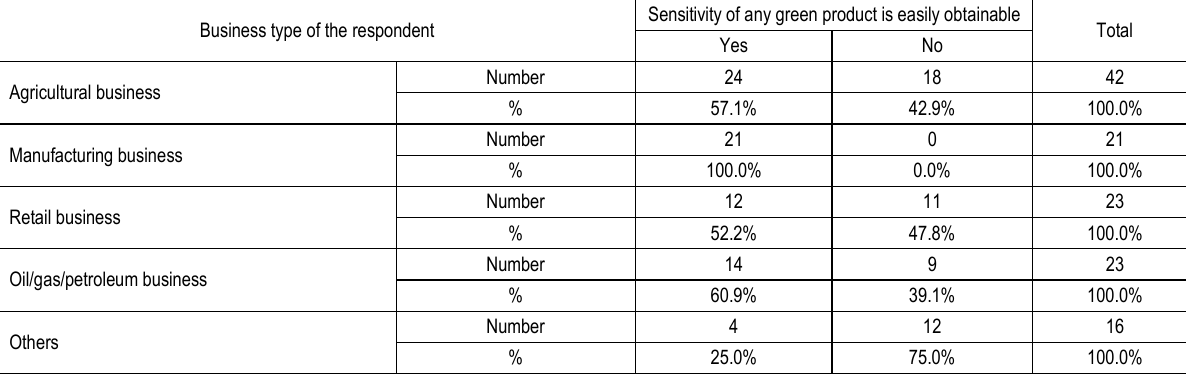
Table 2. Connection between business type and sensitivity of any green